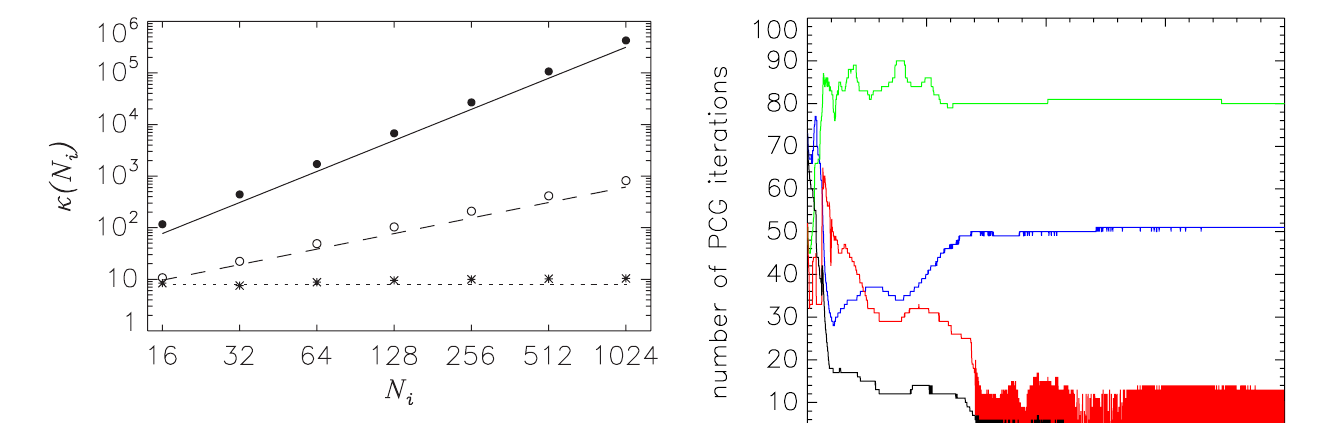
FIG. 4. Condition number (cid:3) for the discretized Laplacian operator with a 3-point stencil as a function of the resolution N : for the nonpreconditioned operator (solid circles; superim- i ); for the operator preconditioned posed against a solid line / N 2 i in wavelet space of Daubechies family of order 2 (empty circles; FIG. 5. (Color) Number of iterations of the PCG algorithm for superimposed against a dotted line / N ). Asterisks denote the the first 2000 steps of a realistic simulation: no preconditioning i ratio of the second largest to the smallest eigenvalues after and zero initial approximation (green line), preconditioning and preconditioning in wavelet space of Daubechies family of order zero initial approximation (blue line), no preconditioning and 2 (dashed line is / const ‘‘smart initial approximation’’ (red line), and preconditioning and ‘‘smart initial approximation’’ (black line). The simulation is done using IMPACT-T PIC code and the Distribution 1 on the Fermilab/NICADD photoinjector (as described later in the text), (cid:4) 32 and Daubechies with N (cid:4) 125 000 particles, resolution N i wavelets of order 2. The computational speedup is quite similar when wavelet thresholding is performed (with and without) the Anscombe transformation. Other wavelet families exhibit the same qualitative behavior. Averages for the entire 30 000-step run are 75.2 for the green line, 60.7 for the blue line, 4.8 for the red line, and 2.4 for the black line.